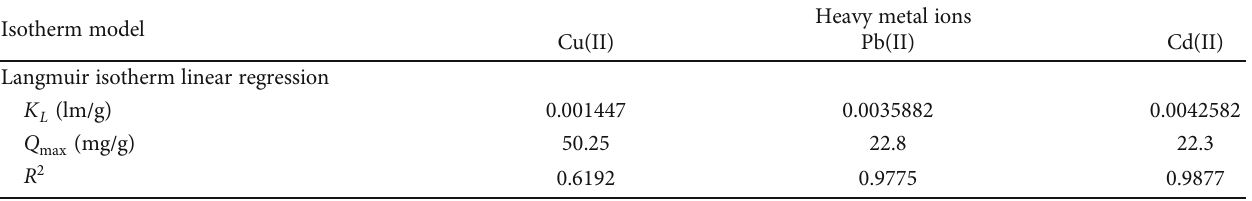
Table 4: Comparison of adsorption capacity of WPE/PAMK-TFN nanocomposite membrane with other reported adsorbents.